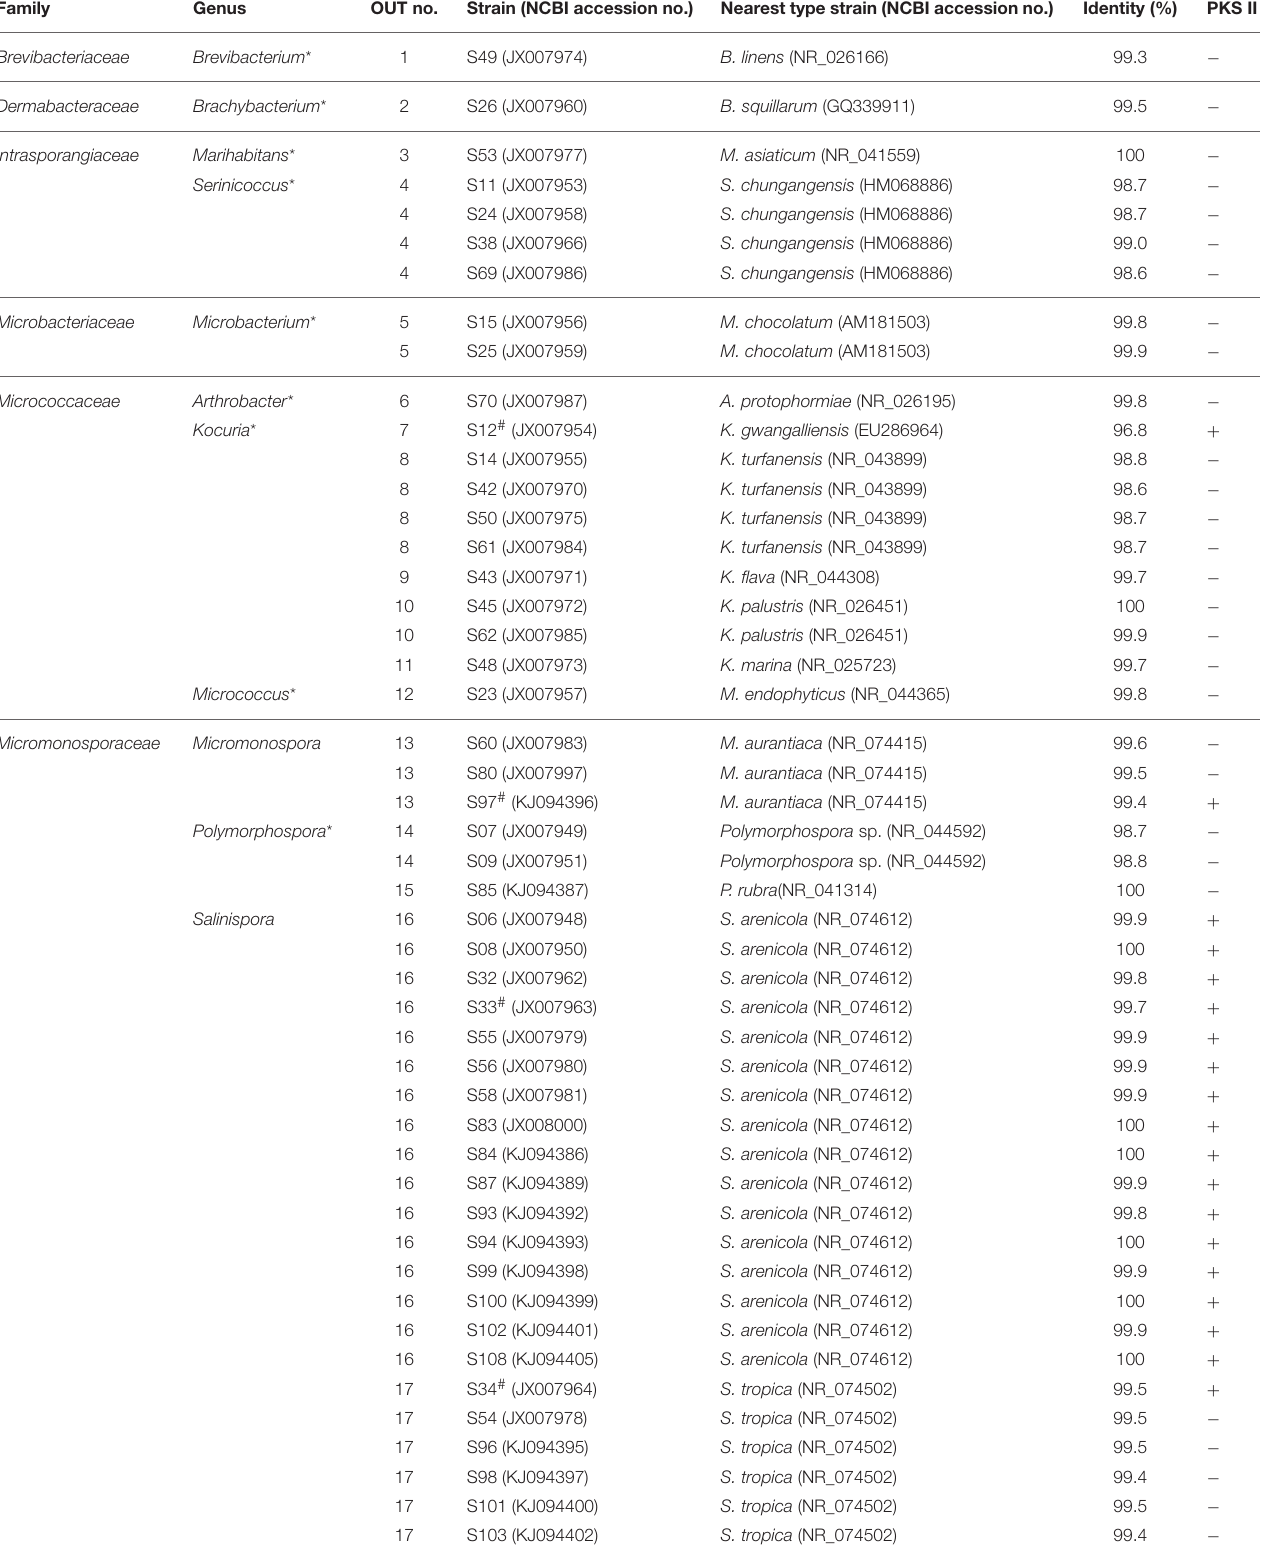
TABLE 2 | Molecular identification of the actinomycetes from South China Sea sponges based on 16S rRNA gene and KS α gene detection. Family Genus OUT no. Strain (NCBI accession no.) Nearest type strain (NCBI accession